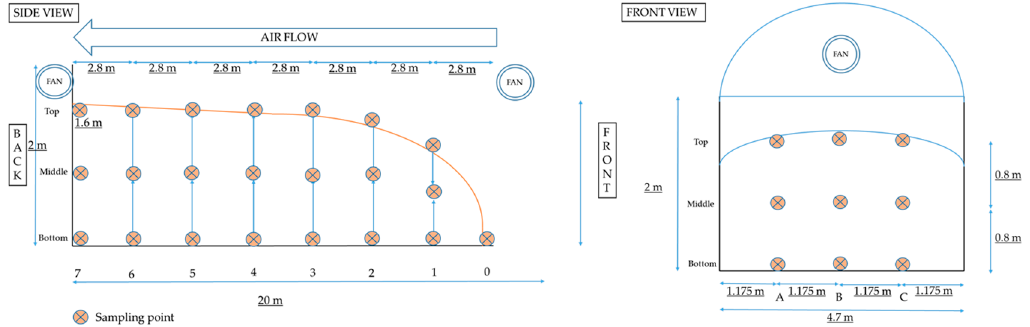
Figure 2. Side and front view of the composting